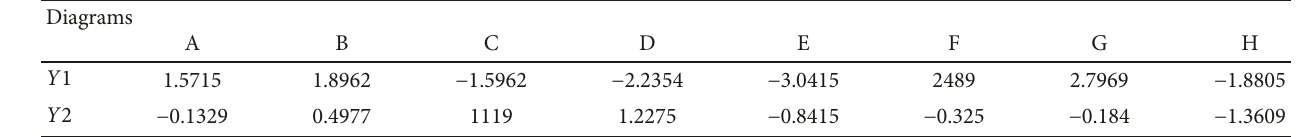
Table 10: Principal components